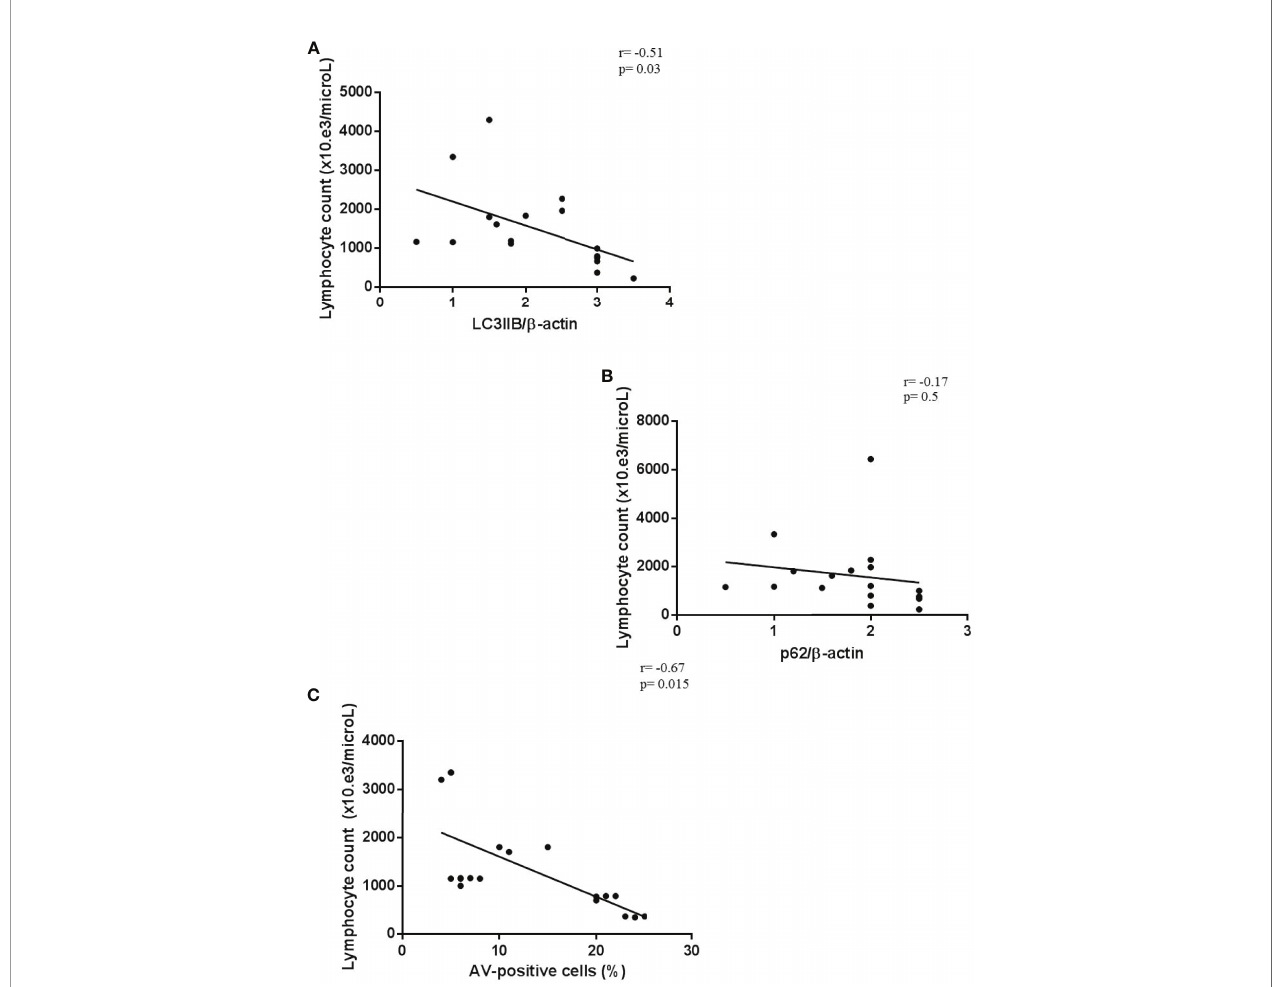
FIGURE 6 | Correlation between lymphopenia and autophagy/apoptotic markers. (A – C) Correlation and linear regression analysis of lymphocyte count and LC3IIB and p62 levels, and apoptosis in PBMCs from COVID-19 patients ( n = 18) (Spearman ’ s rank correlation). PBMC, peripheral blood mononuclear cell; COVID-19, coronavirus disease